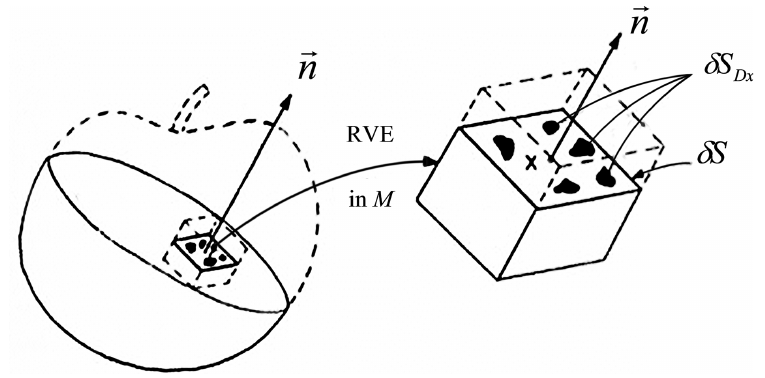
Figure 2: Damaged RVE in a damaged body.